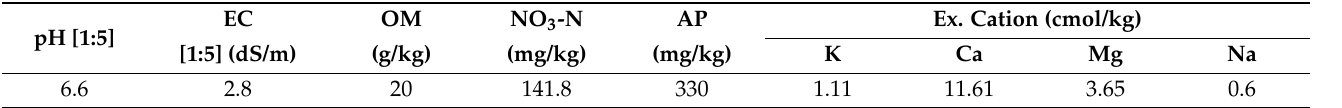
Table 1. Physicochemical properties of the soil used in the